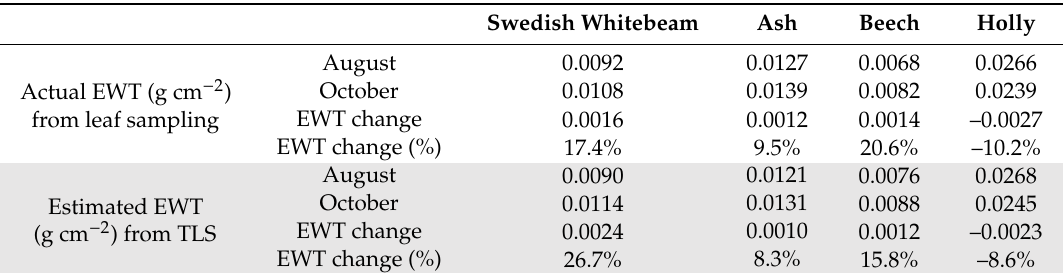
Table 5. Detecting temporal change in EWT between August and October for the four trees used in the EWT estimation validation. A positive sign indicates an increase in EWT, while a negative sign indicates a decrease.